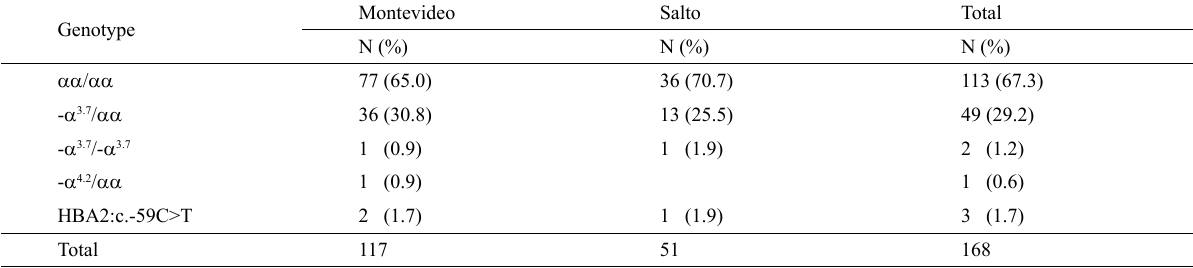
Table 1 – Alpha thalassaemia mutations found in the Uruguayan microcytic and hypochromic sample. Montevideo Genotype